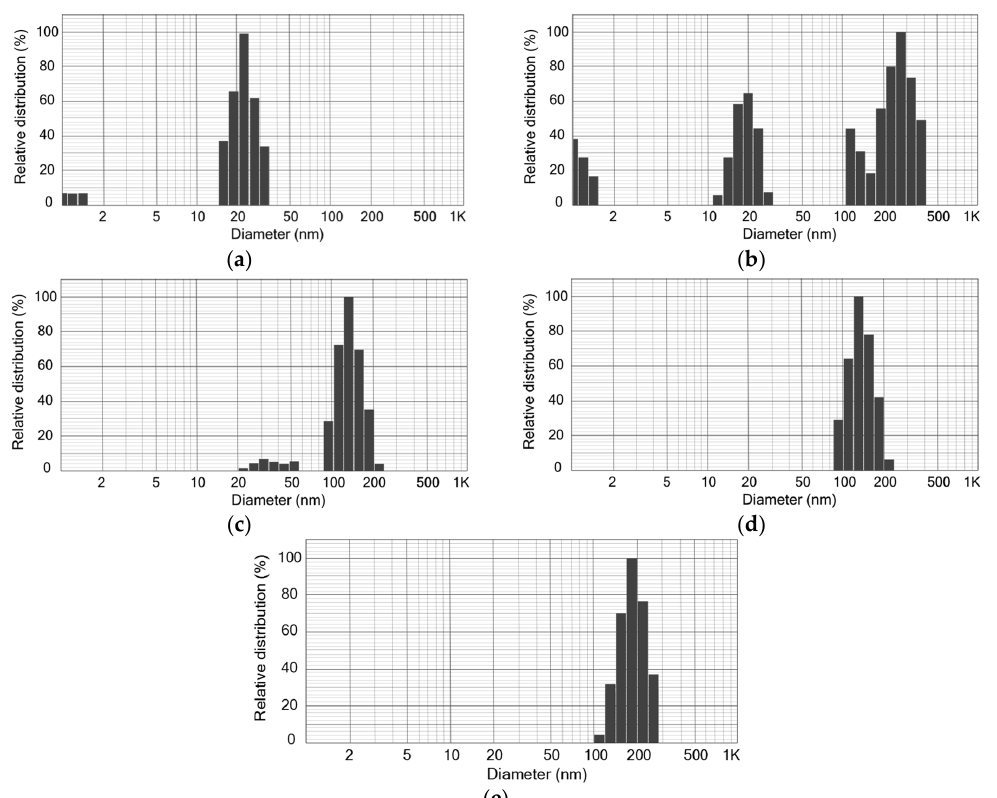
Figure 3. Particle size distribution of the decantate from batch settling experiments involving ( a ) 28 nm SiO 2 NPs; ( b ) 28 nm SiO 2 NPs + activated sludge; ( c ) 144 nm SiO 2 NPs; ( d ) 144 nm SiO 2 NPs + activated sludge and ( e ) activated sludge only.